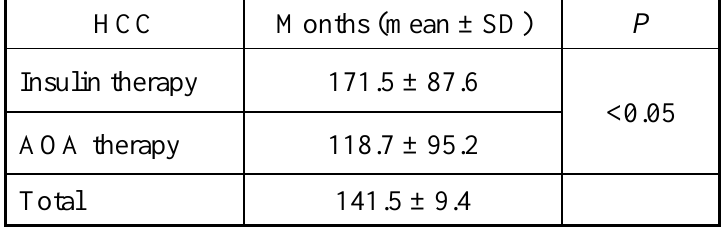
Table 5. Duration of DM2 before HCC diagnosis and antidiabetic